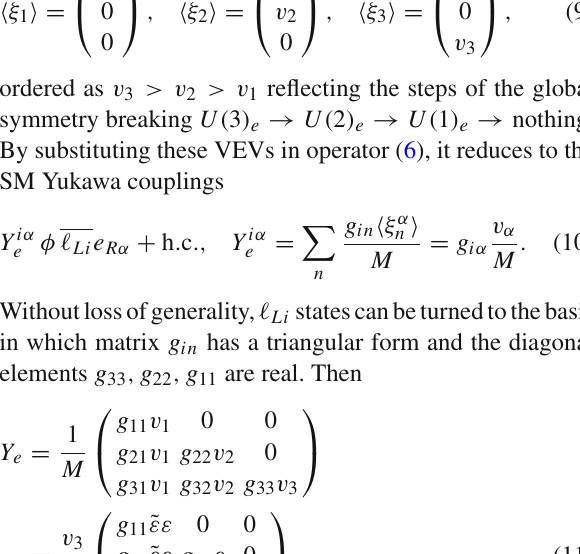
Fig. 1 Upperdiagramrepresentsoperator(6)andlowerdiagramshows how it can be obtained via seesaw exchange of heavy vector-like fermions (8)